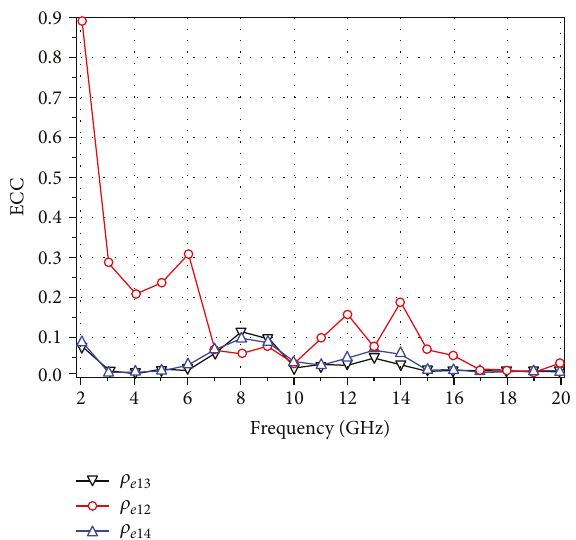
Figure 10: Simulated ECCs between the elements of the